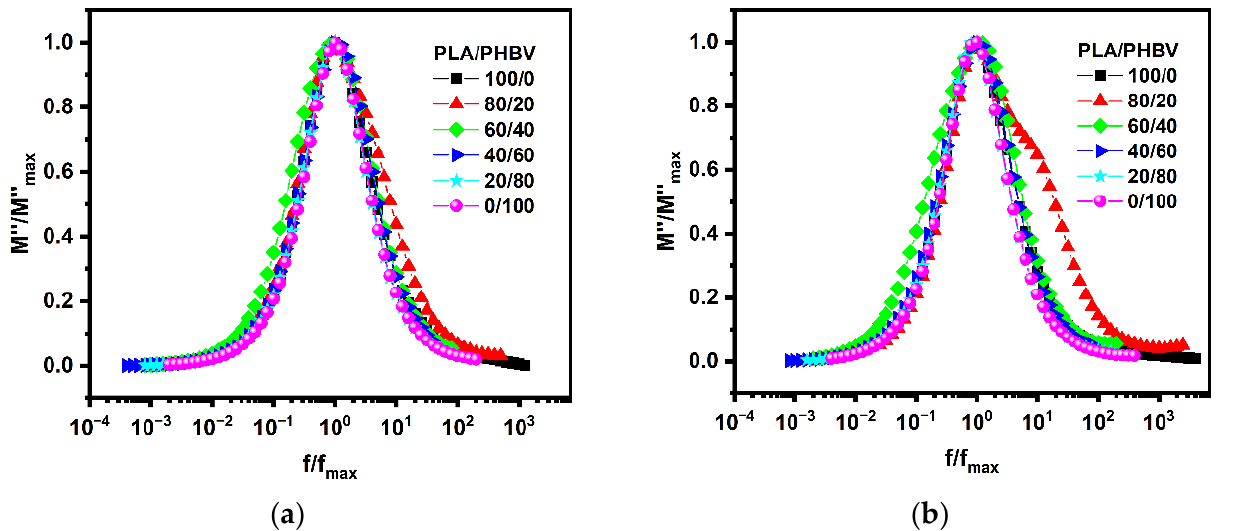
Figure 17. Normalized frequency dependence of M (cid:48)(cid:48) for the conductivity relaxation of PLA/PHBV blends with various compositions at 185 °C ( a ) and 150 °C ( b ).